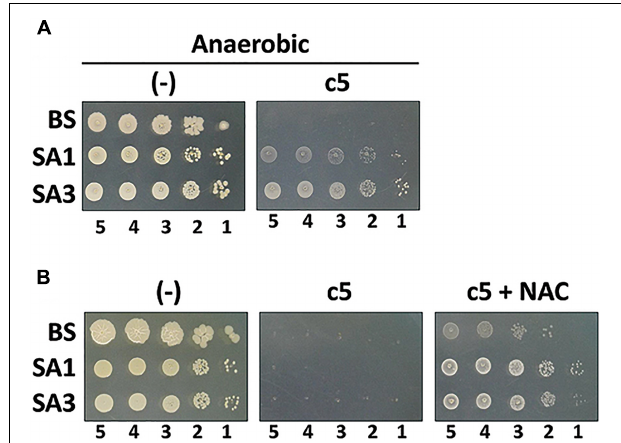
FIGURE 5 | Antibacterial activity under ROS-compromising conditions. (A) Antibacterial activity of c5 under anaerobic condition. The Gram-positive bacterial cells ( B. subtilis , BS; S. aureus MSSA, SA1; S. aureus MRSA, SA3) were grown to the logarithmic growth phase. Ten-fold serial dilutions from the cell cultures were spotted onto an LB agar plate (–) and an LB agar plate containing 5.0 µ g/ml of c5. (B) Antibacterial activity of c5 in the presence of N -acetylcysteine (NAC) under aerobic condition. The bacterial cells in A were grown to the logarithmic growth phase. Ten-fold serial dilutions from the cell cultures were spotted onto an LB agar plate (–) and LB agar plate containing 5.0 µ g/ml of c5 with (c5+NAC) or without (c5) 10 mM NAC. The numbers indicate the log(CFU) of the applied bacterial